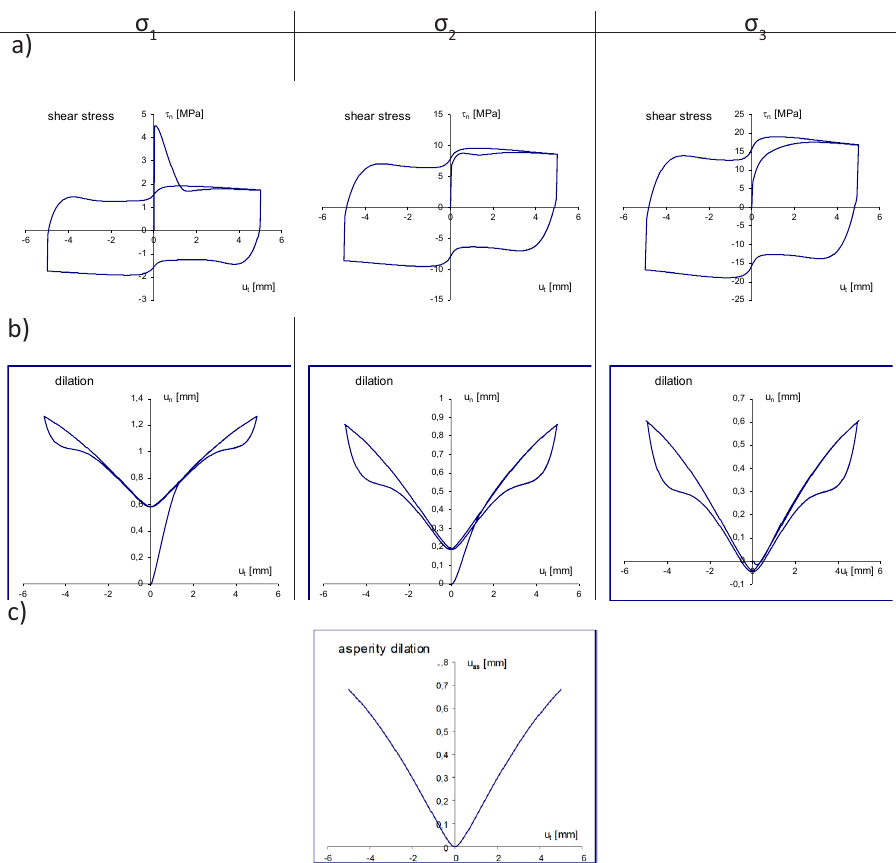
< σ < σ , ρ = 2.3 10 3 kg/m 3 , q = 25° , asperities ) depending on the tangential 1 2 3 ini max